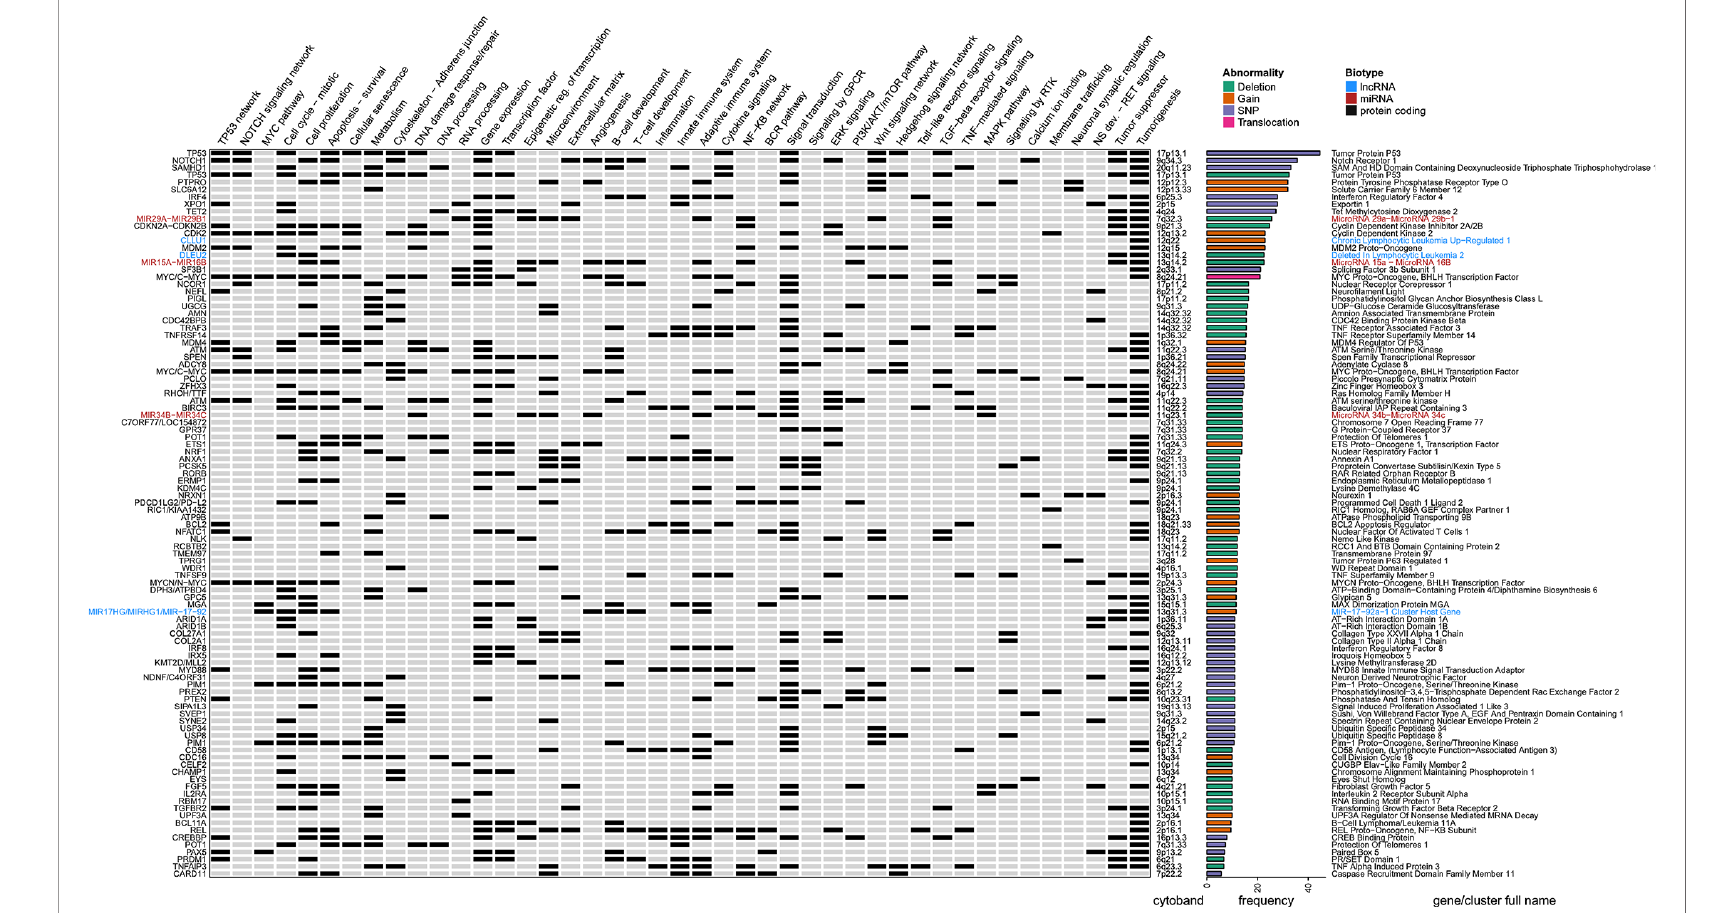
FIGURE 1 | Genomic landscape of Richter syndrome. Genes recurrently mutated and related cellular functions altered in RS as a manually curated heat map of available data from 4 landmark papers, gathering a total of 207 RS patients. From left to right (for each gene): gene name, functional annotations and related pathways (according various databases and literature), cytogenetic band, nature of the reported abnormality (deletion, gain, translocation, or single nucleotide variant) and full gene name written according to a color-code indicating biotype (black: protein coding gene; red: miRNA and blue: lncRNA). Selection thresholds: 5% occurrence in cohorts of at least 50 samples for CNVs and 10 samples for SNPs. BCR, B-cell Receptor; CNV, Copy Number Variation; GPCR, G Protein-Coupled Receptor; lncRNA, Long Non-Coding RNA; MAPK, Mitogen-Activated Protein Kinase; miRNA, MicroRNA; NS, Nervous System; RS, Richter Syndrome; RTK, Receptor Tyrosine Kinase; SNP, Single Nucleotide Polymorphism; TGF, Transforming Growth Factor; TNF, Tumor Necrosis